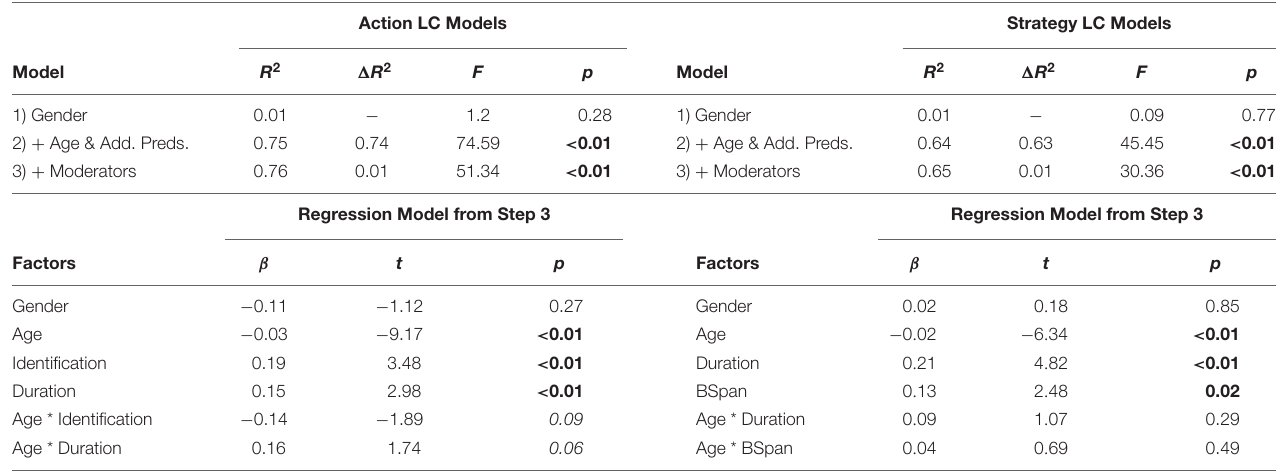
TABLE 5 | Results of moderator